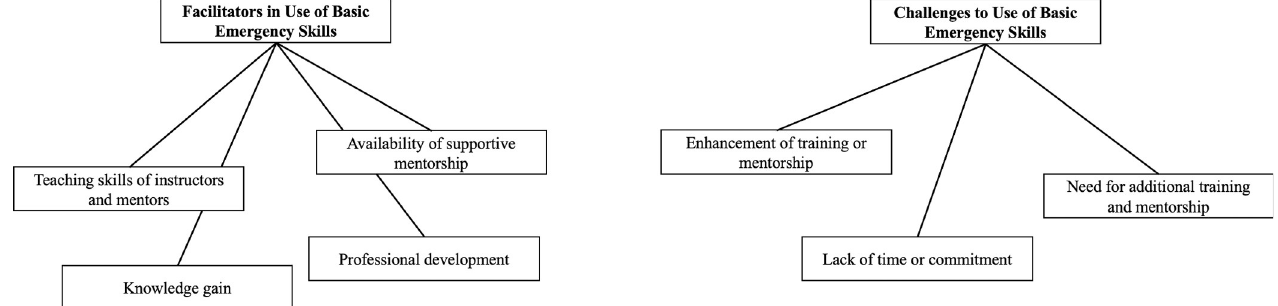
Fig 3. Mapping themes of facilitators and challenges of basic emergency skill use in Neno District.